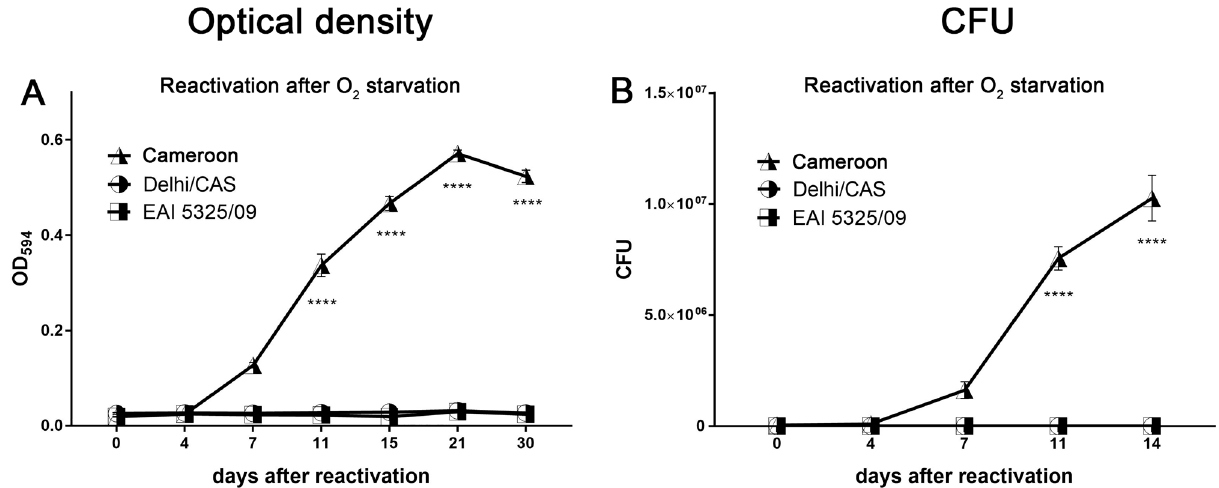
Figure 7. After hypoxia-induced dormancy, Cameroon (L4), but not EAI (L1) and Delhi/CAS (L3) reactivated after oxygen exposure. 35 days after oxygen starvation, M. tuberculosis strains were inoculated in fresh medium under atmospheric oxygen conditions. At indicated time points, mycobacterial growth was measured by optical density ( A ) or bacteria were plated for CFU analysis ( B ). Growth curves of Cameroon (L4) were significantly higher compared to EAI (L1) and Delhi/CAS (L3) from day 11 on. n = 3 independent experiments (EAI, Cameroun), n = 1 independent experiment (Delhi/CAS) with triplicates in each, ****p < 0.0001, two-way